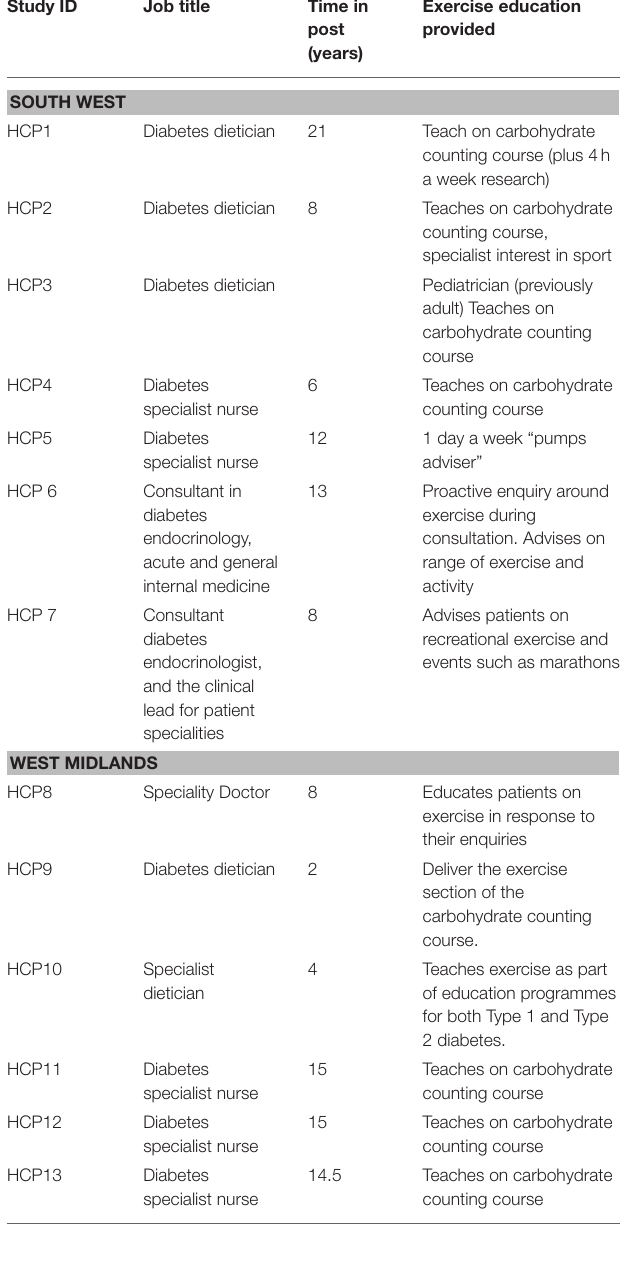
TABLE 2 | Staff participants. TABLE 3 | Influences on the successful delivery of exercise education: themes and